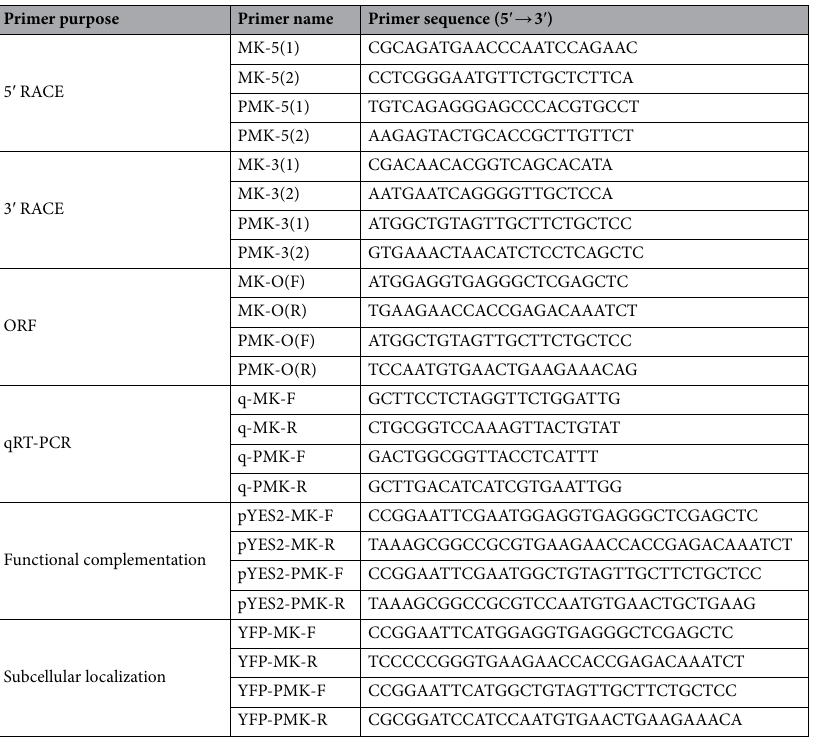
Table 3. Primers used for related experiments in this